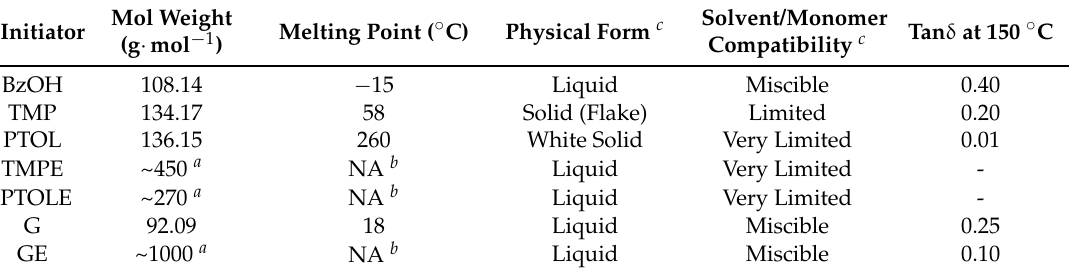
Table 2. Physical Characteristics of the Initiators Used in this